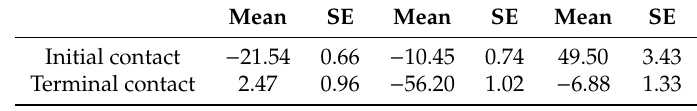
Table 1. Average initial and terminal contact time di ff erence (mean ± SE) of kinematic versus kinetic gait event detection methods (GEDM) in milliseconds (ms). CBTA: coordinate-based treadmill algorithm; SK: shank angular velocity algorithm; FVA: foot vertical acceleration algorithm.